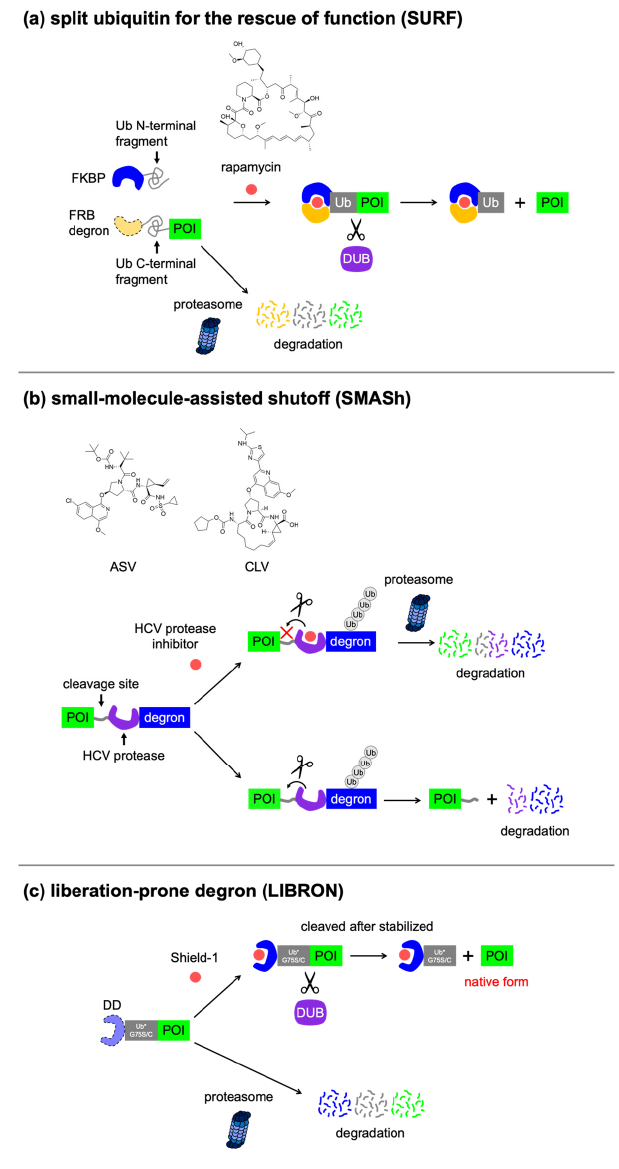
Figure 6. Excisable degrons. Concepts of ( a ) SURF, ( b ) SMASh, and ( c ) LIBRON.